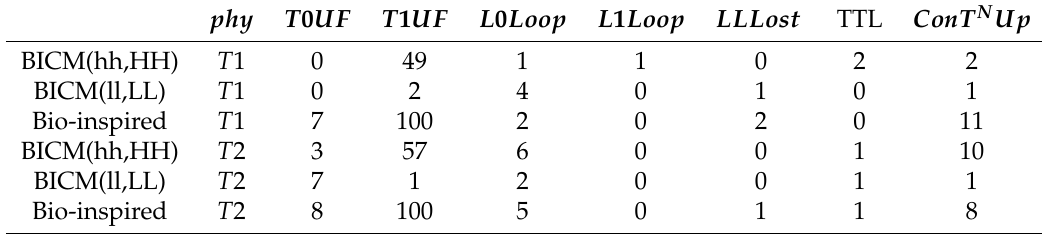
Table 8. Number of trials in which the data delivery ratio fails to recover due to the inconsistency in tables when nodes are removed by targeted